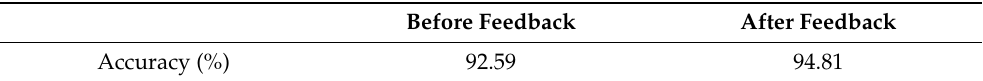
Table 8. The performance of the ADHD screening diagnostic tool using MLP before and after reflecting feedback.